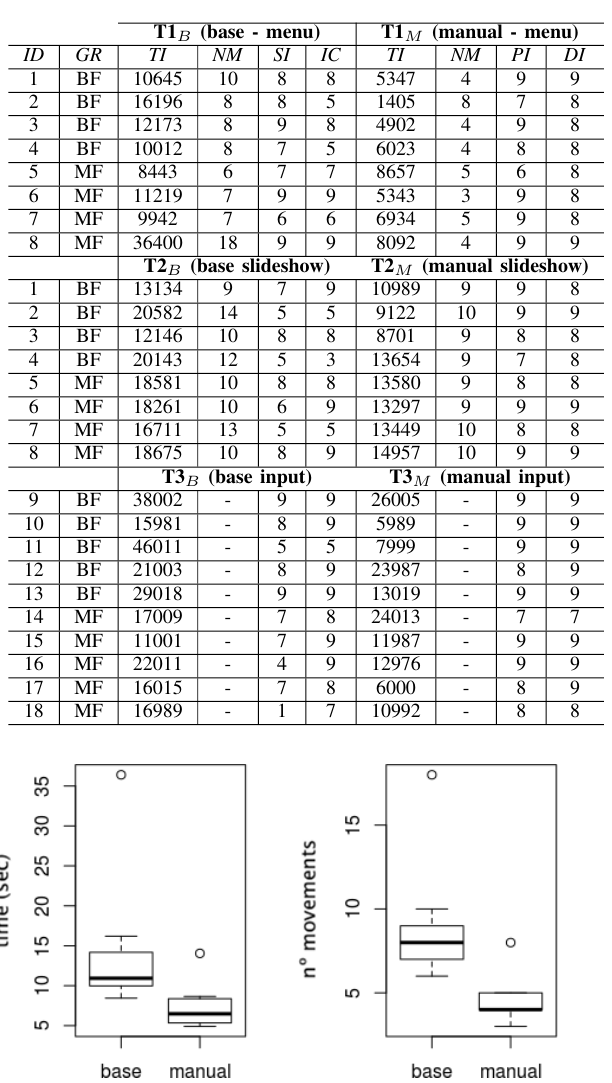
TABLE III U SERS ’ OUTCOMES IN THE TASKS .